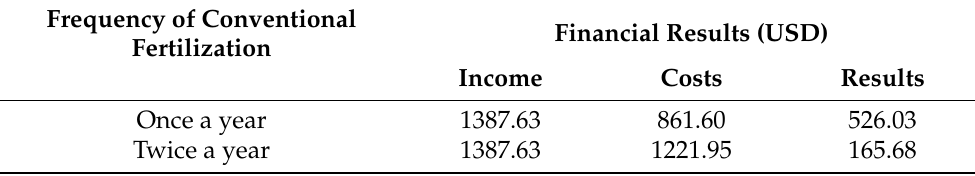
Figure 4. Comparison of the income and costs (in USD) of conventionally amended crops and with the addition of biochar. Table 3. Comparison of the financial results for single and double soil fertilization with conven- tional